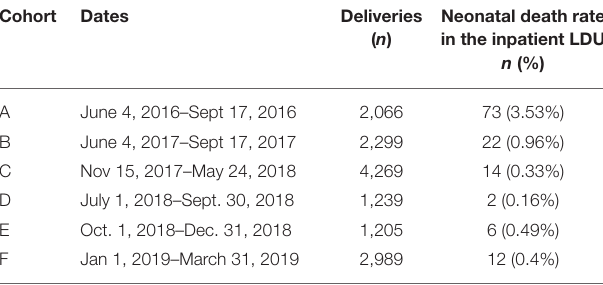
TABLE 3 | Neonatal death rate in the inpatient LDU before and after the implementation of the NALS service. Cohort Dates Deliveries